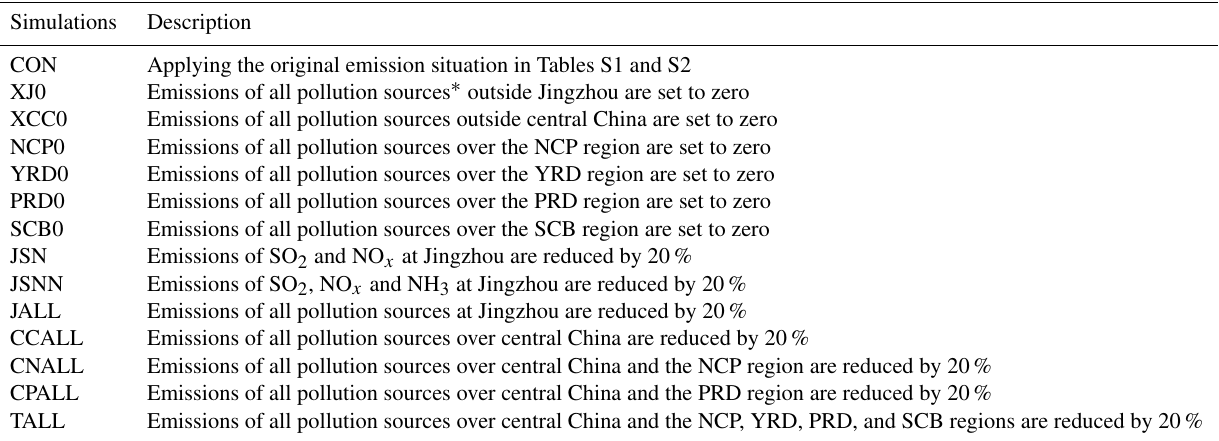
Table 2. Description of sensitivity simulations by the GEOS-Chem model. The NCP, YRD, PRD, and SCB are the areas framed in red shown in Fig. 1.